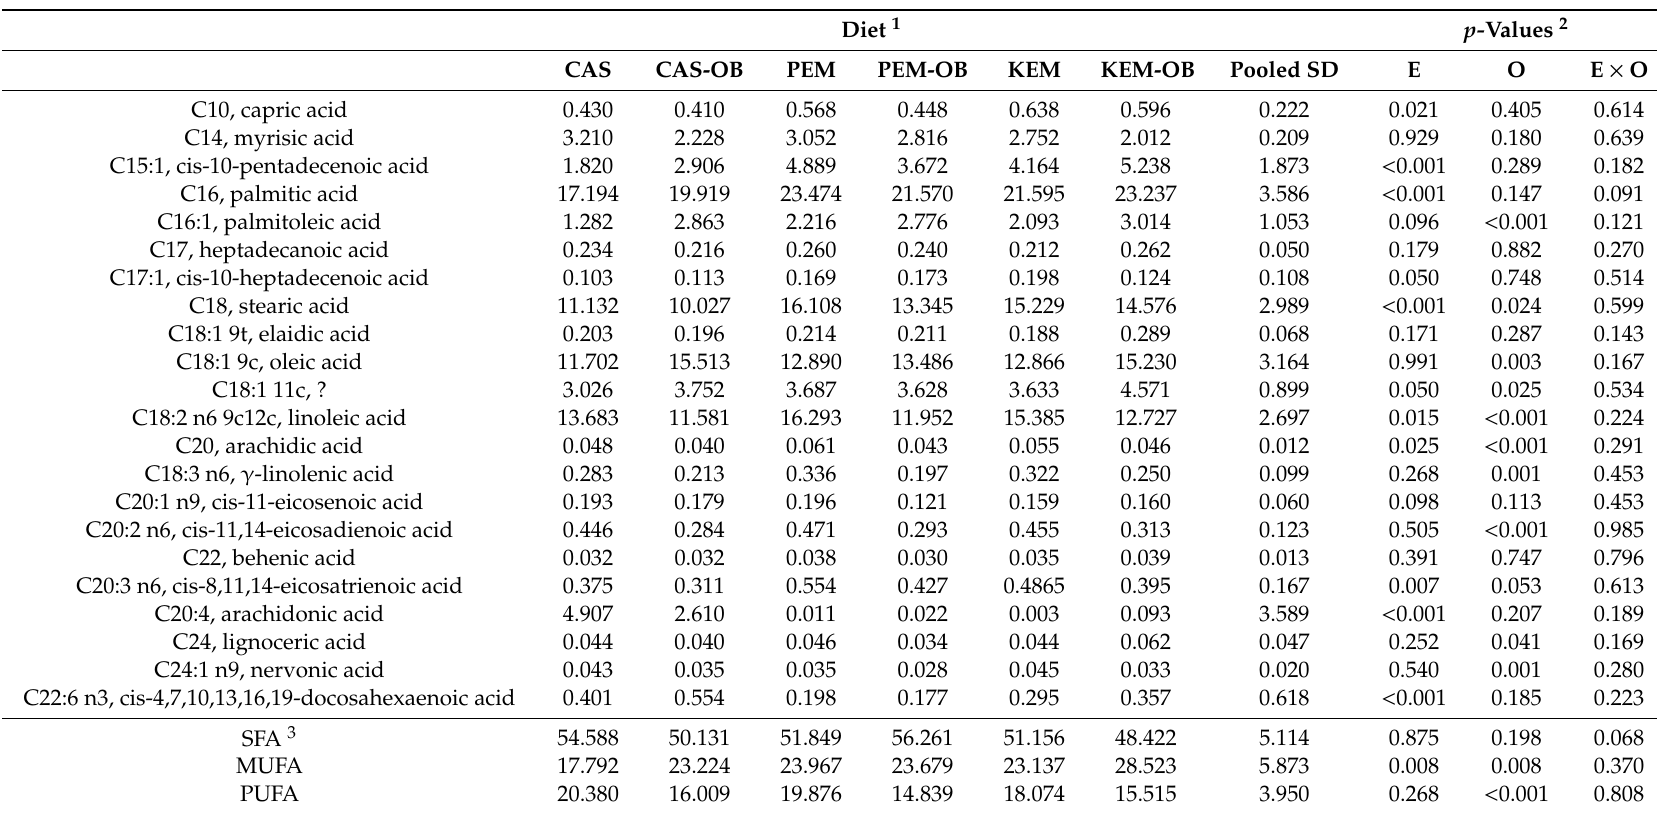
Table 7. E ff ect of the diet on liver long chain fatty acid (LCFA) composition of rats fed control diets (CAS) or diets supplemented with two extruded mixes of legumes plus cereals, normocaloric or